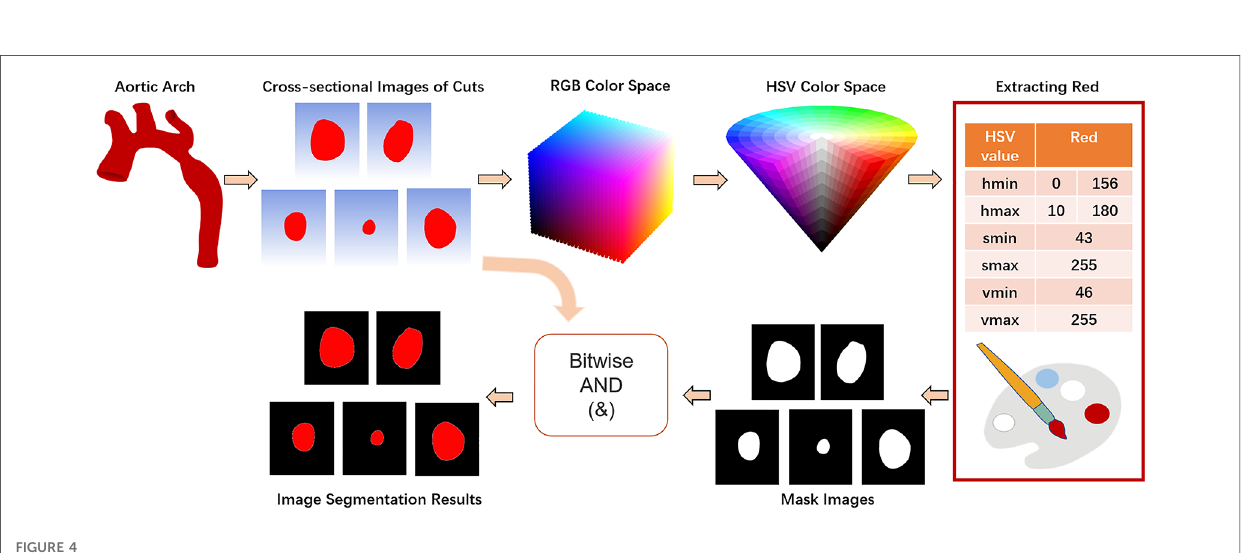
FIGURE 4 Color segmentation